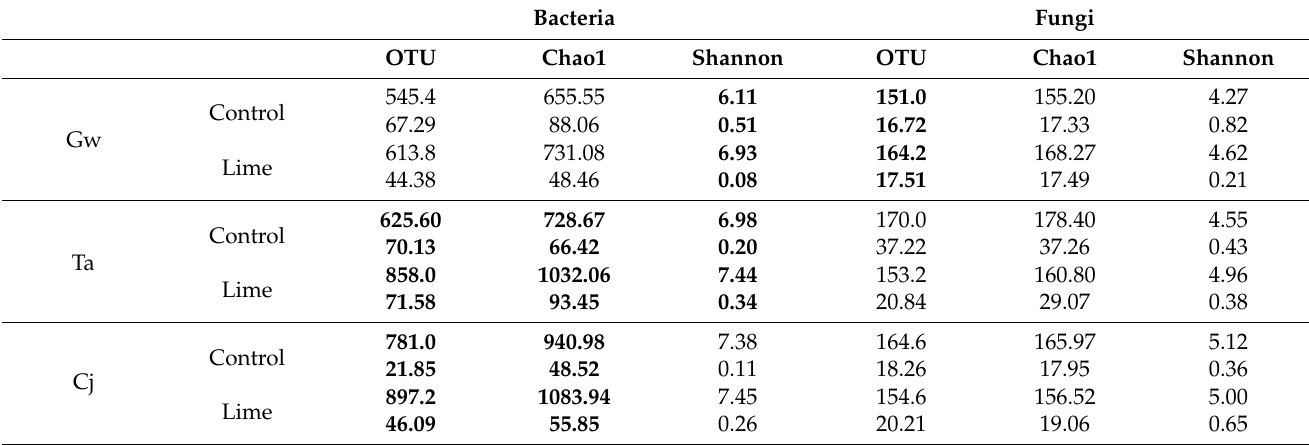
Table 3. Soil microbial community richness and diversity index of study